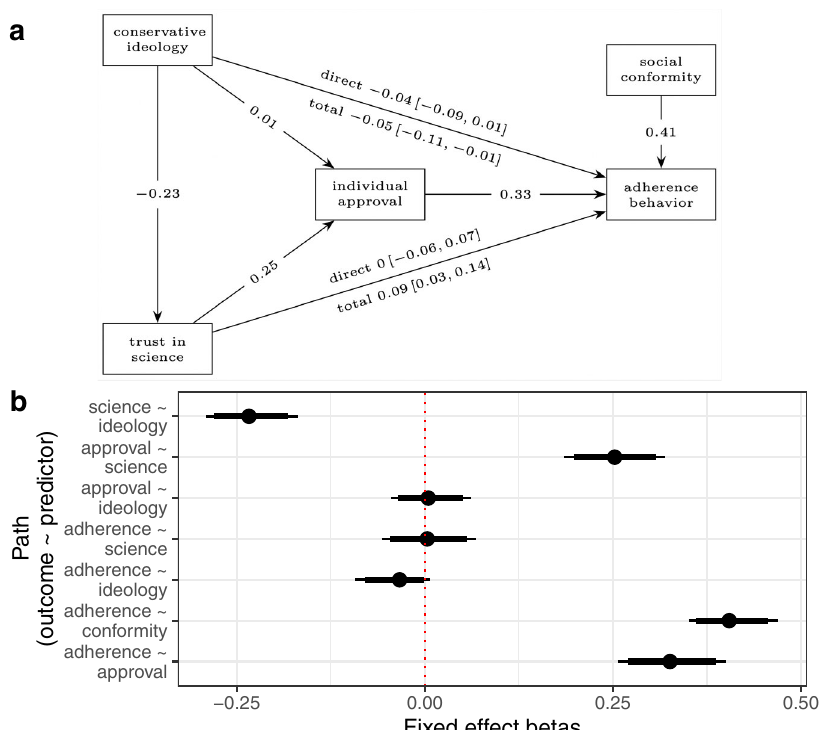
Fig. 2 Pathways and posterior samples for path analysis. See Table S1 for justi fi cations for each pathway. a Model pathway standardised coef fi cients, including 95% CIs for the direct and total effects of science and conservative ideology. b Posterior samples for model fi xed effects, with whiskers showing 89% (thick) and 95% (thin)